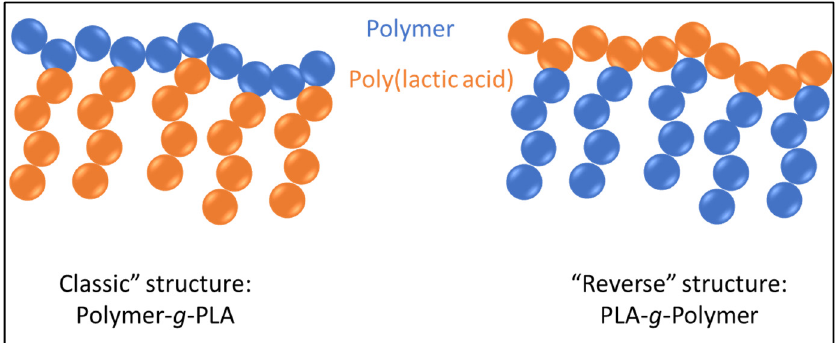
Figure 1. Illustration of “classic” and “reverse” structures of PLA-based graft copolymers .